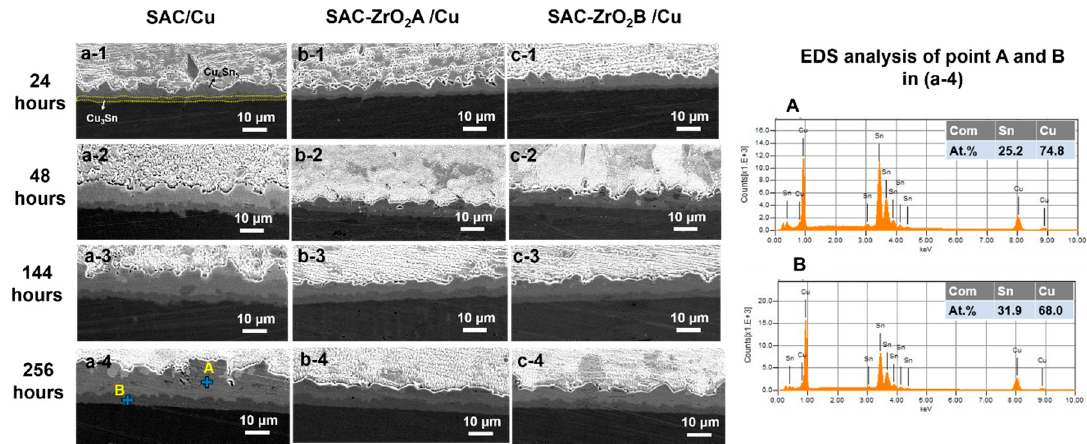
Figure 5. SEM micrograph of Cu-Sn IMC layer at the interface of the 175 °C isothermally aged ( a ) SAC 305/Cu, ( b ) SAC 305-ZrO2A/Cu and ( c ) SAC 305-ZrO2B/Cu joints for various aging time, A, B are the